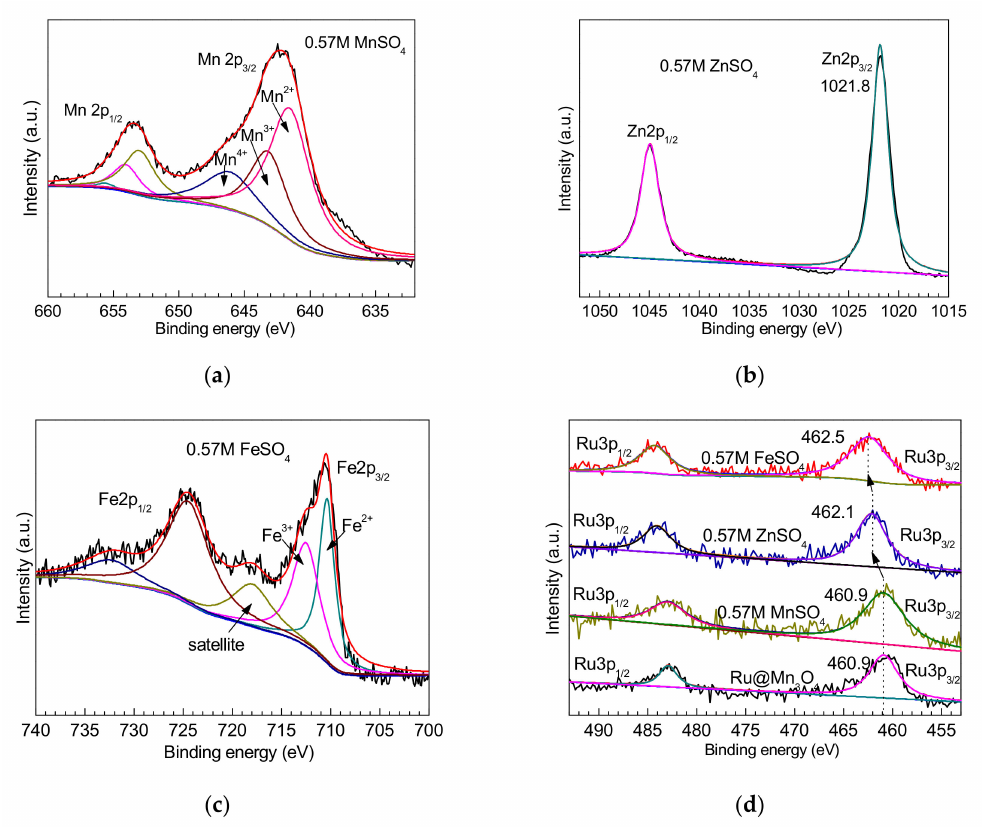
Figure 5. XPS profiles of spent Ru@Mn 3 O 4 (0.46) catalyst with 0.57 mol L − 1 of ZnSO 4 , MnSO 4 and FeSO 4 as additives, respectively. ( a ): Mn 2p of spent Ru@Mn 3 O 4 (0.46) catalyst with 0.57 mol L − 1 MnSO 4 ; ( b ): Zn 2p of spent Ru@Mn 3 O 4 (0.46) catalyst with 0.57 mol L − 1 ZnSO 4 ; ( c ): Fe 2p of spent Ru@Mn 3 O 4 (0.46) catalyst with 0.57 mol L − 1 FeSO 4 and ( d ) Ru 3p of the fresh Ru@Mn 3 O 4 (0.46) catalyst and the spent Ru@Mn 3 O 4 (0.46) catalyst with 0.57 mol L − 1 of ZnSO 4 , MnSO 4 and FeSO 4 as additives. Composition of spent Ru@Mn 3 O 4 (0.46) with applying 0.28 mol L